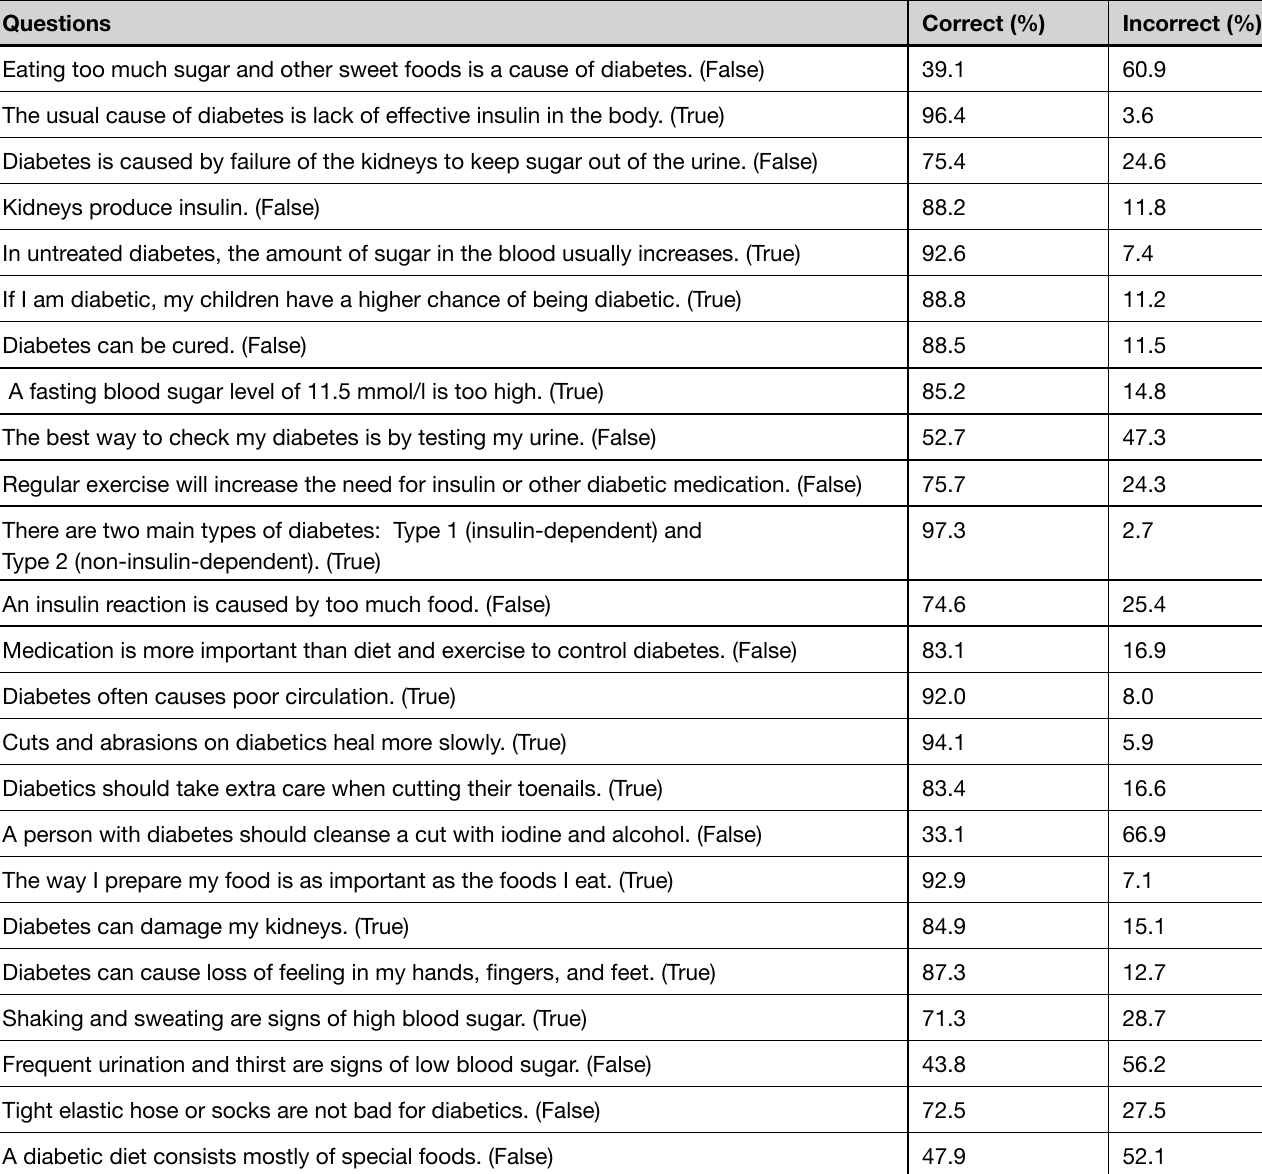
Table 1: Responses to the 24-item Diabetes Knowledge Questionnaire (n=338)